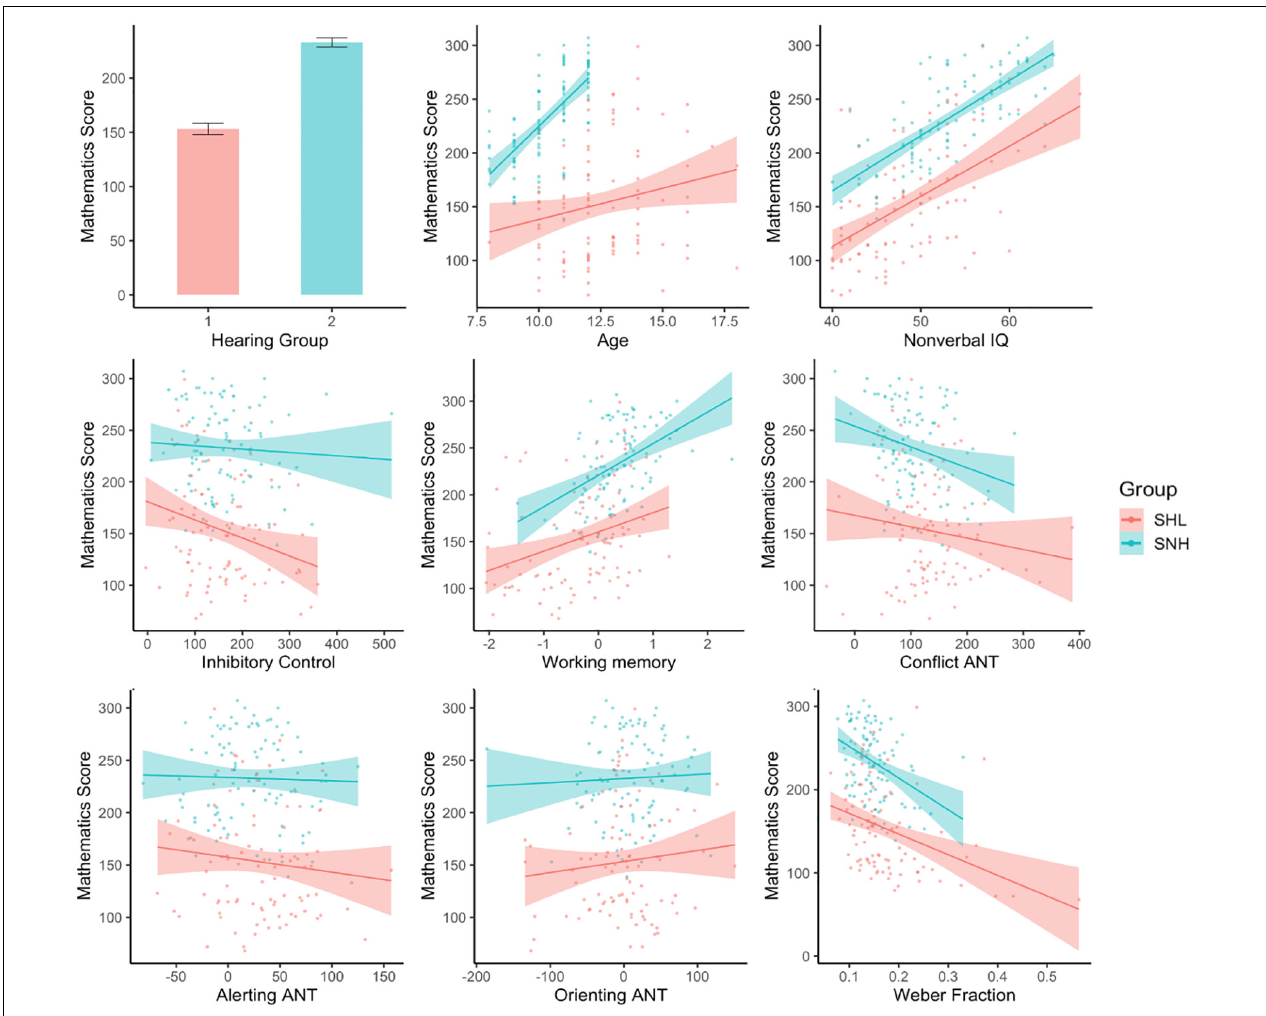
FIGURE 6 | Predicting mathematics score. When other variables were taken into account, only group, Non-verbal IQ, Inhibitory Control, and Weber fraction significantly predicted Mathematics